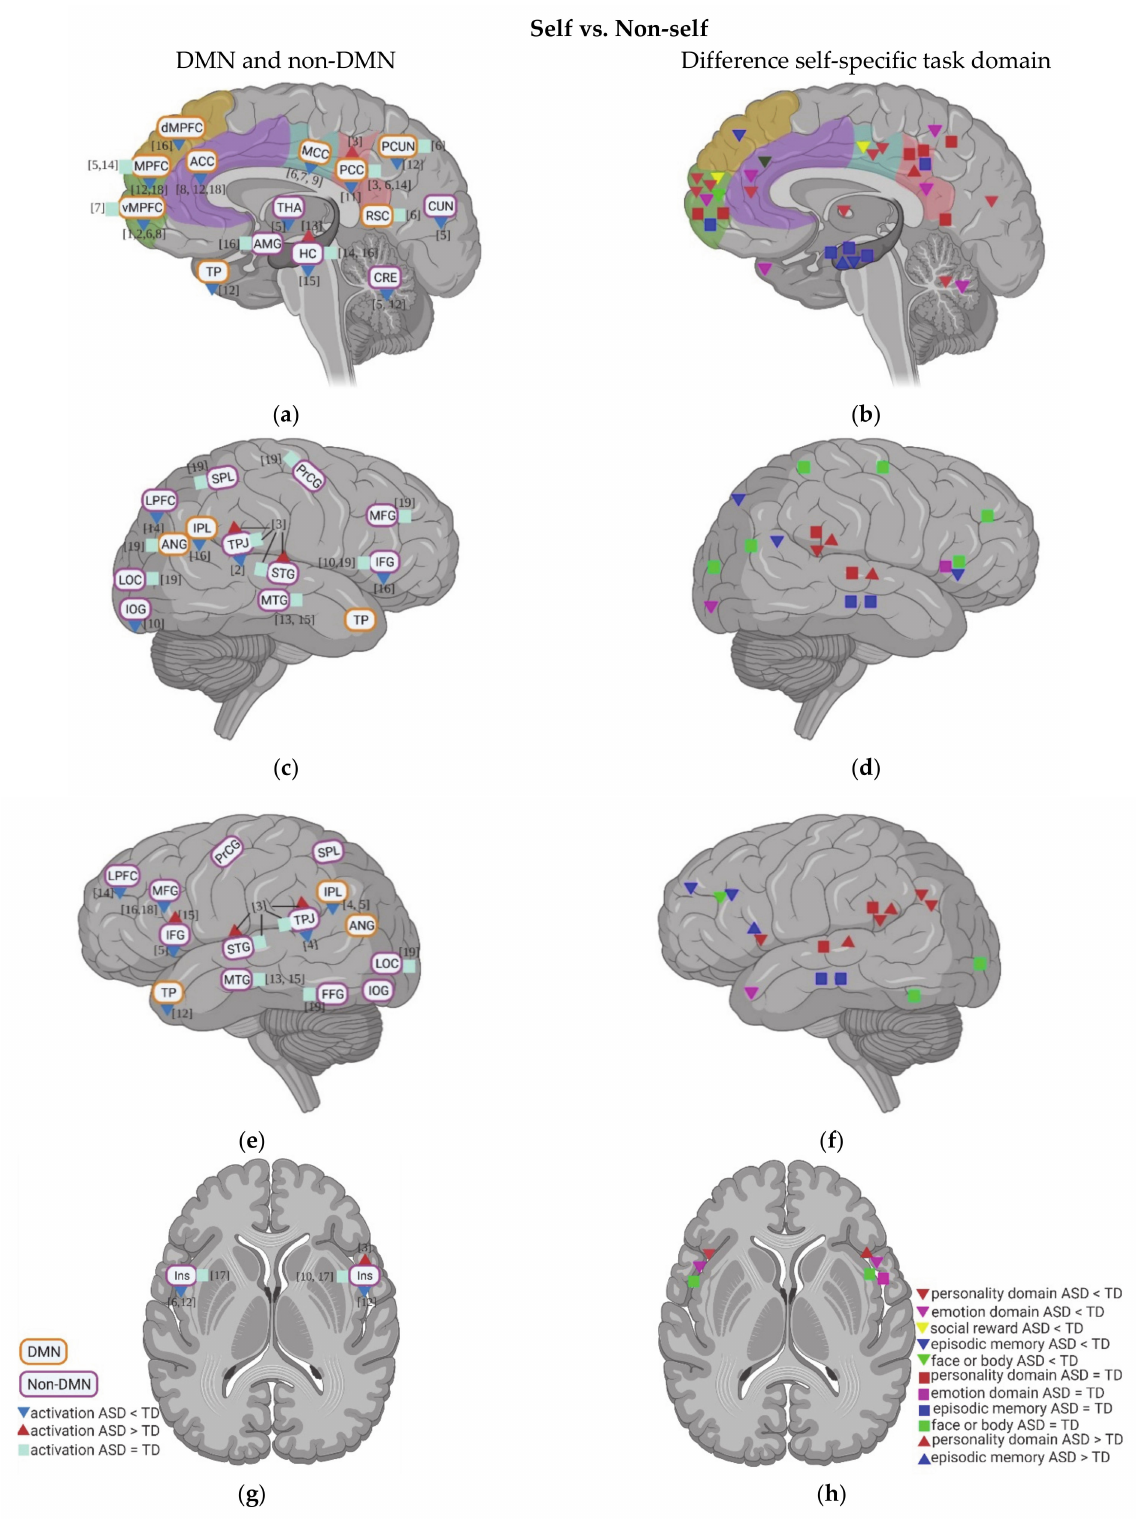
Figure 1. Activation of DMN and non-DMN regions for individuals with ASD compared to TD during self-specific tasks in different studies (left side) and different domains (right side): ( a , b ) DMN, subcortical regions and cerebellum (CRE); ( c , d ) related regions in right lateral hemisphere; ( e , f ) related regions in left lateral hemisphere; ( g , h ) insula (Ins). The numbers in the figure correspond to the study numbers in Table